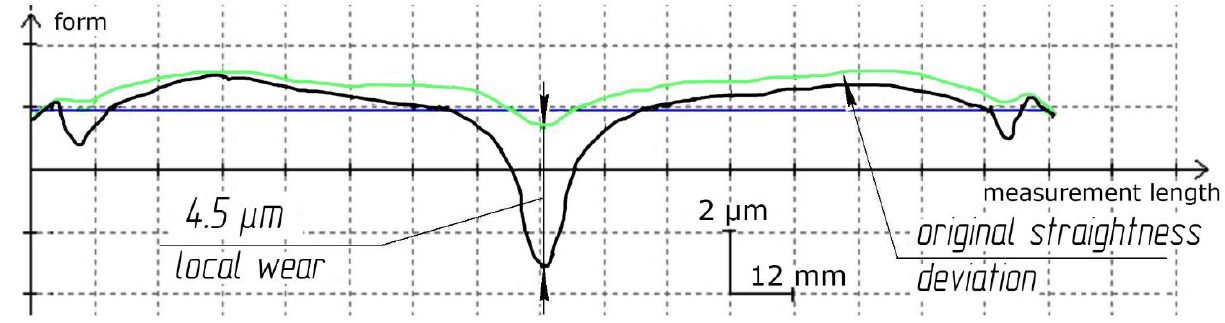
Figure 7. The lapp wear value as a result of real processing conditions.